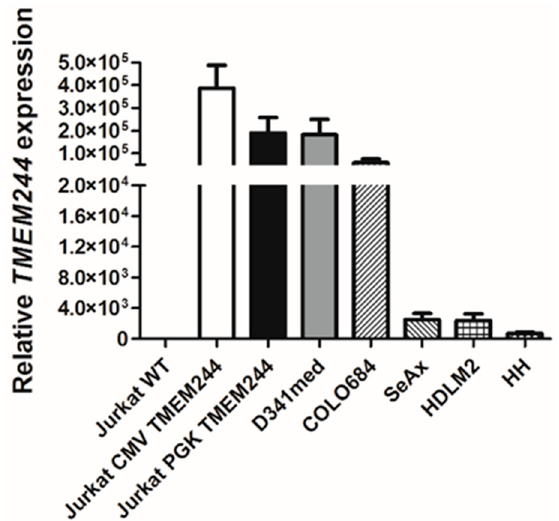
Figure 1. Relative TMEM244 expression analyzed using RT-qPCR in cell lines with endogenous expression and in cell lines stably transduced with TMEM244 ORF vectors. The expression was normalized to beta-2-microglobulin. Data are represented as mean ± SD ( n = 3).